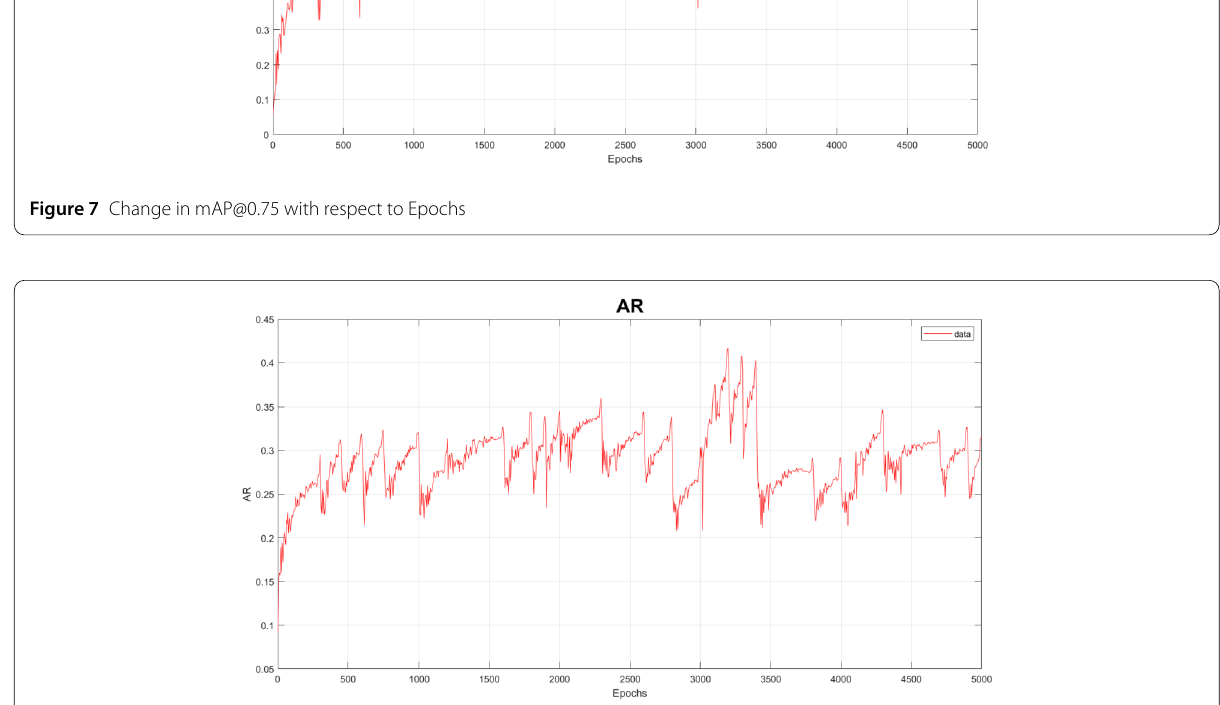
Figure 8 Change in AR with respect to Epochs